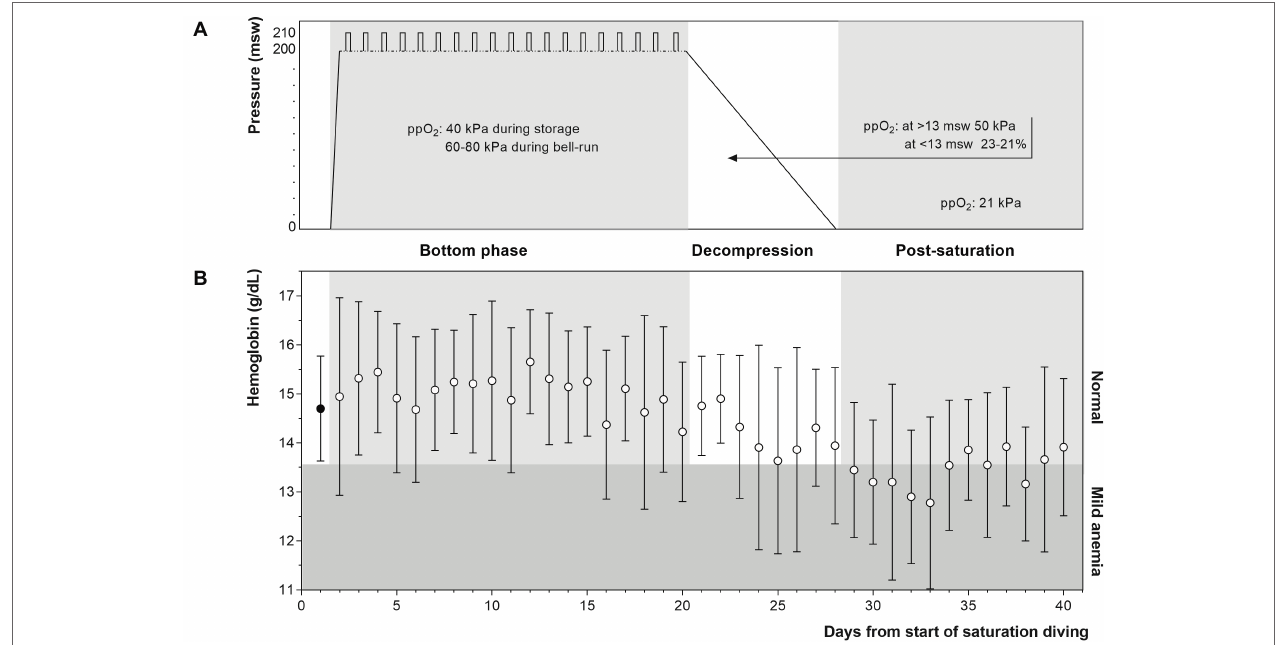
FIGURE 2 | (Panel A) Heliox saturation profile. Daily bell-runs for work excursions are indicated by vertical bars on the bottom phase profile. During the bottom phase, ppO 2 was kept at 40 kPa in the pressure chamber and increased to 60–80 kPa during bell-runs. In the decompression phase, ppO 2 was initially raised to facilitate the elimination of helium, and gradually lowered during the final 13 m toward the surface to avoid explosion hazards. (Panel B) Daily Hb levels (mean ± SD) at baseline (filled circle), and during ( n = 11) and following ( n = 9–7) 4 weeks of commercial saturation diving (open circles). Hb ≤ 13.6 g/dl was graded as mild